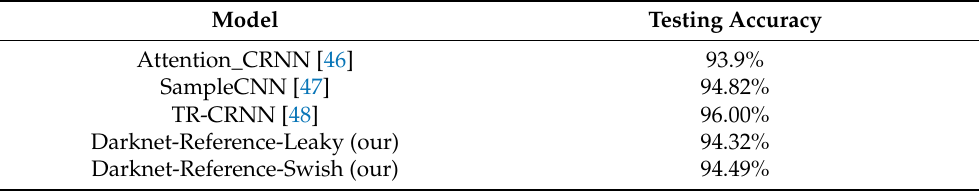
Table 3. Accuracy of the test set of the Google command database (V2) using 35